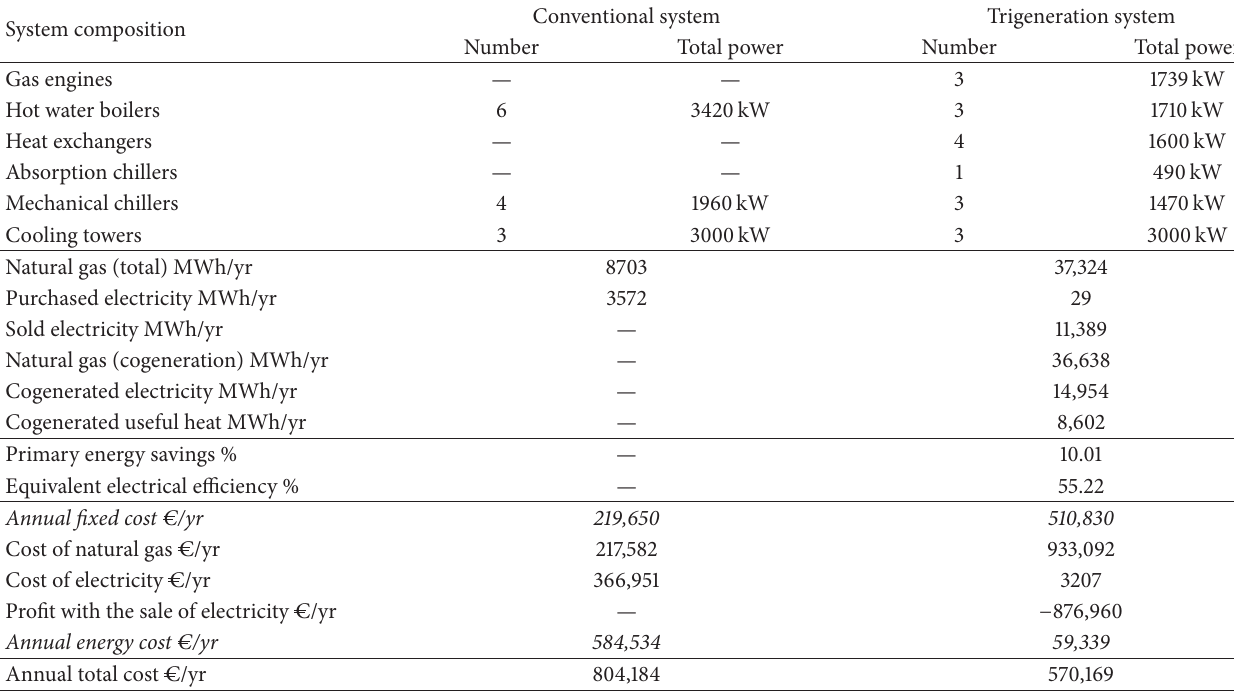
Figure 3: Structure and annual operation of the conventional system. Table 2: Results for optimal trigeneration system (base case) and conventional